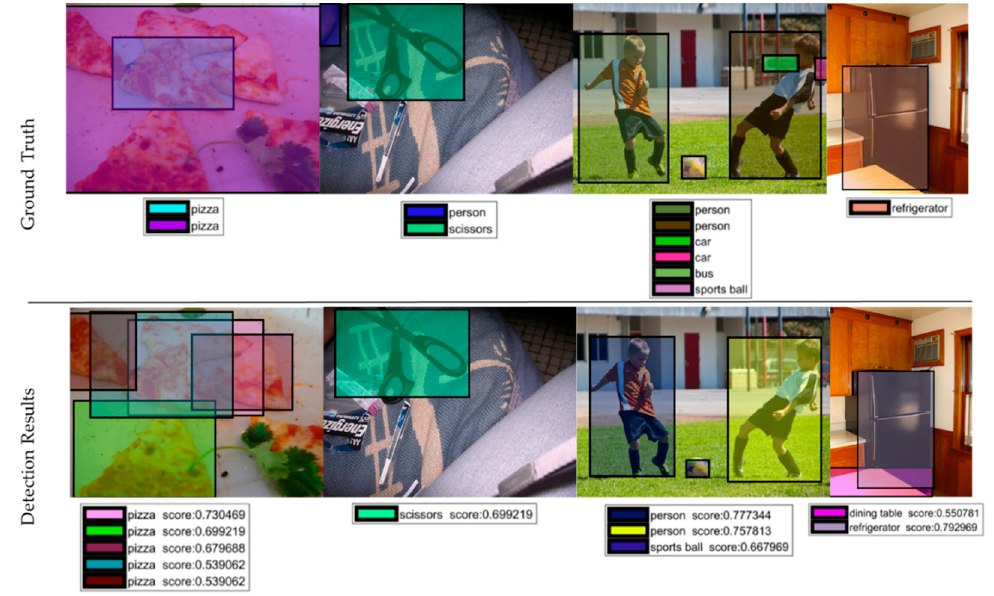
Figure 12. Some interesting detection results.